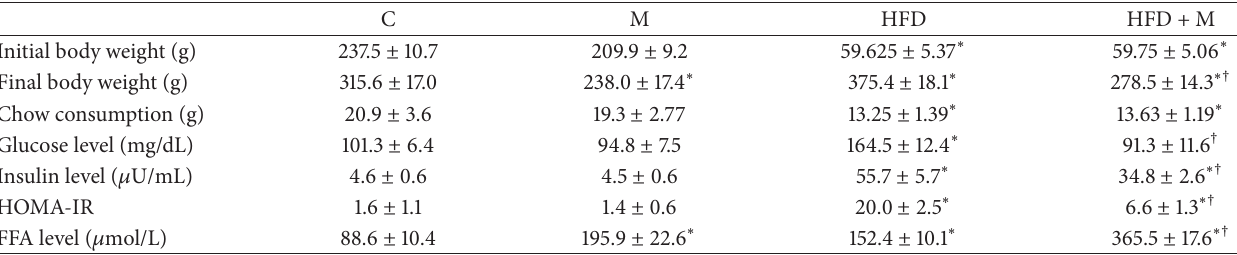
Table 1: Effect of myriocin treatment (for 7 days) and high fat diet feeding (for 5 weeks) on body weight, chow diet consumption, fasting serum glucose level, fasting serum insulin level, the Homeostasis Model Assessment of Insulin Resistance (HOMA-IR) index, and serum FFA level [ 𝑛 (per group) = 8].